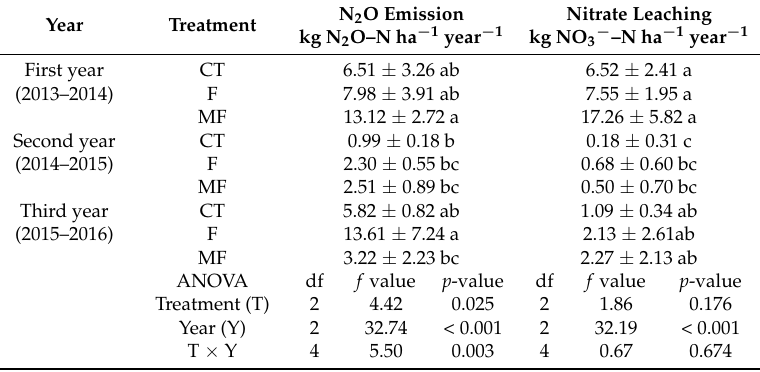
Table 4. Annual N 2 O emission and annual NO 3 − –N leaching after renovation in the unfertilized control treatment (CT), chemical fertilizer treatment (F), and combined manure and chemical fertilizer treatment (MF). Values are mean ± standard deviation. Same letters besides the values denote no significant difference ( p <